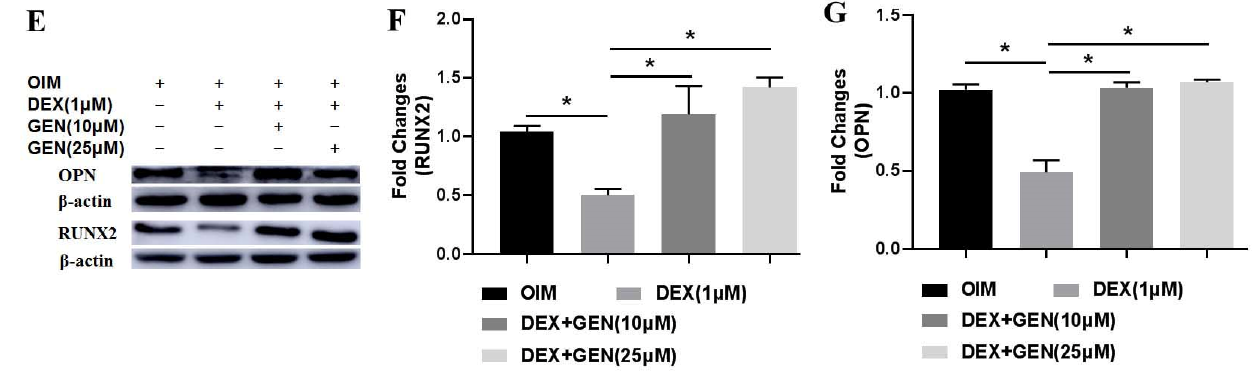
Figure 2. GEN ameliorated DEX-induced inhibition of osteoblast differentiation. ( A ) The immunohistochemical study of RUNX2 and OPN in the bone trabecula of the rat proximal femurs ( × 40 magnification). The staining intensity of RUNX2 ( B ) and OPN ( C ) was evaluated. ( D ) The ALP staining and the Alizarin Red S staining assays were conducted ( × 100 magnification). The protein expression of RUNX2 ( E , F ) and OPN ( E , G ) were determined by western blot. All experiments were implemented separately in triplicate. * p < 0.05; ** p < 0.01. NC, negative control; 50 mg/kg, Dex + 50 mg/kg GEN; 100 mg/kg, Dex + 100 mg/kg